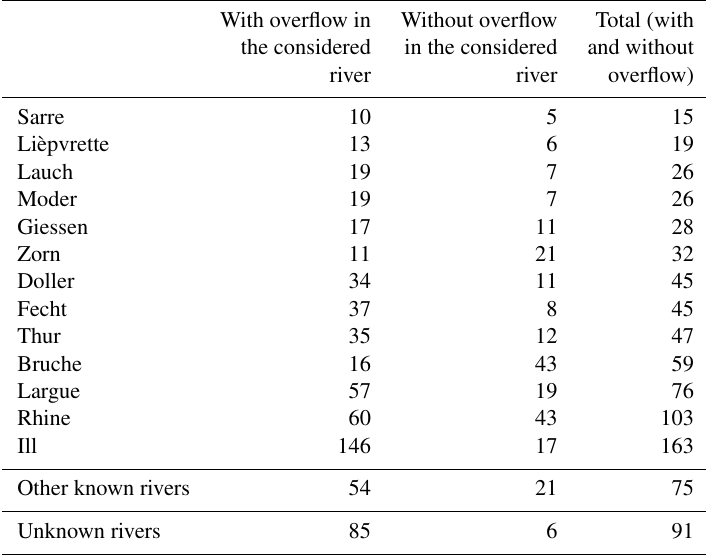
Table 6. Number of events per river. The 13 rivers for which at least 10 events with water overflow were documented are listed. ORRION also documents flood events (with and without water overflow) that have affected other known rivers, as well as rivers that could not be identified in the available sources.